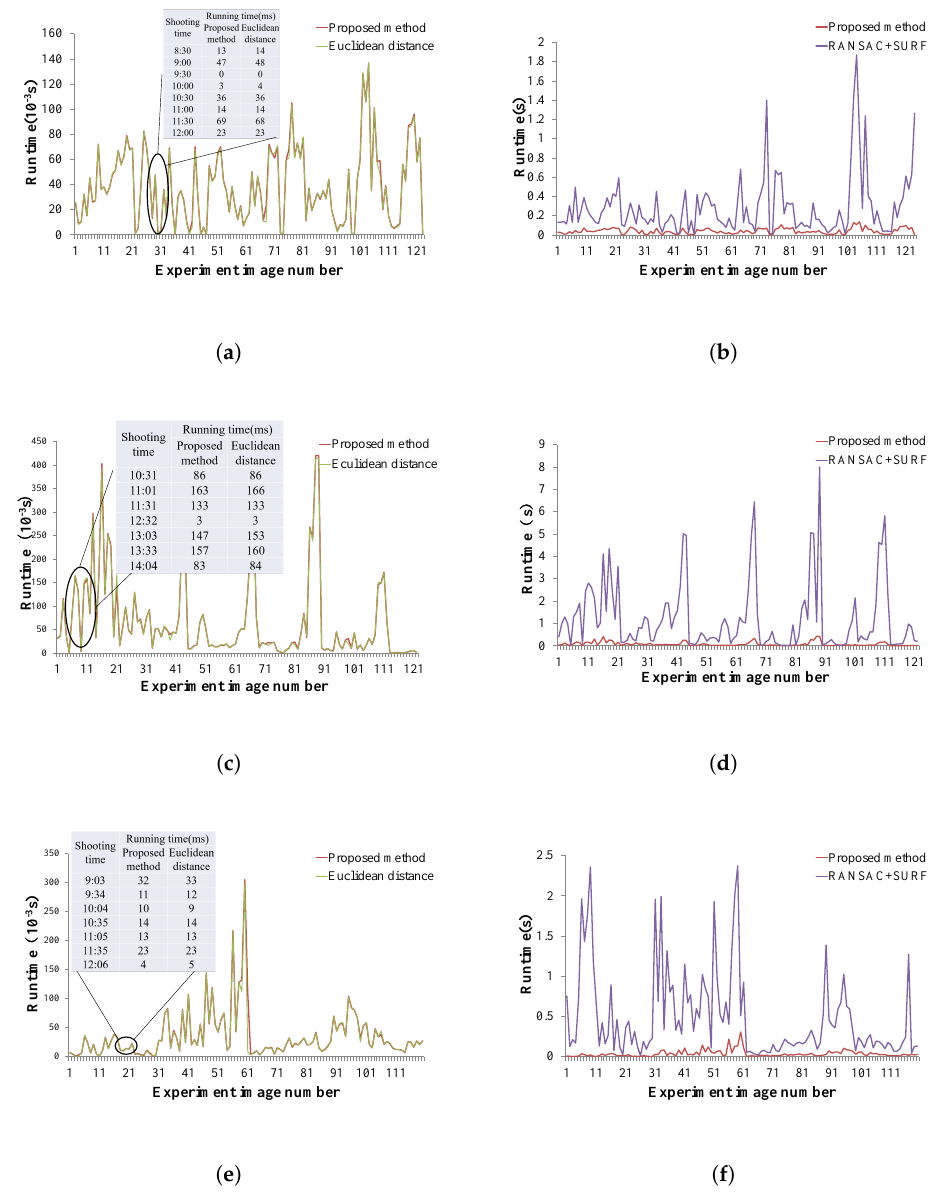
Figure 14. Comparison of three methods on runtime: ( a , b ) 29 February–6 March 2016 (14–20 km), ( c , d ) 8–15 March 2017 (4–10 km) and ( e , f ) 18–23 August 2018 (8–14 km).